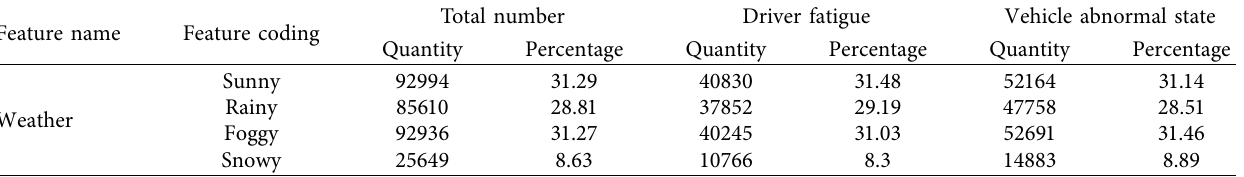
Table 4: Distribution of bus forewarning types under different weather conditions.